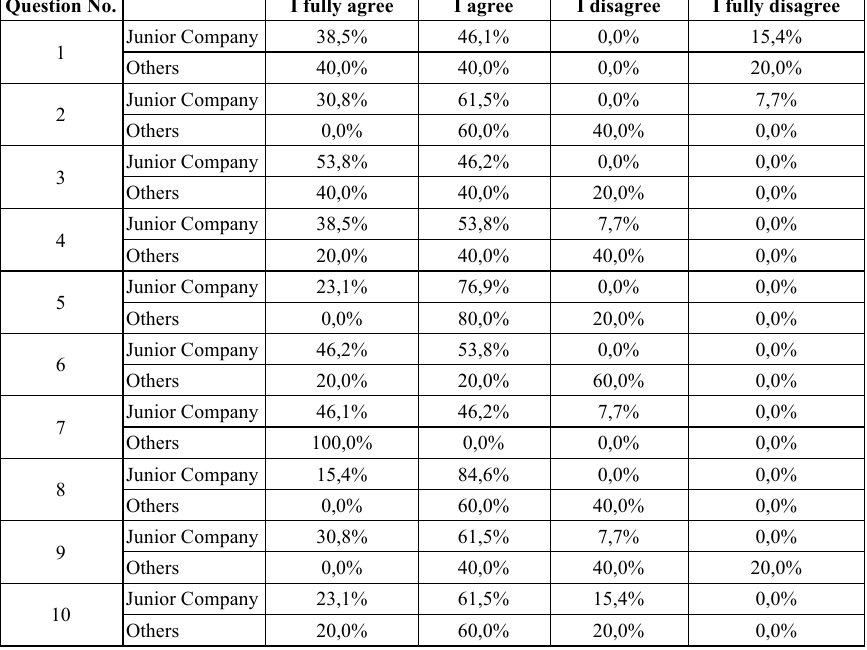
Table 1. Preliminary results of the